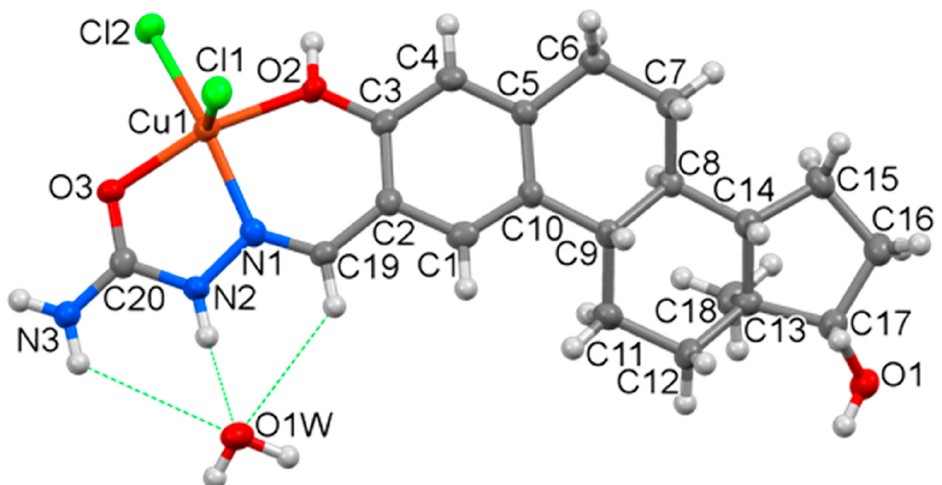
Figure 4. Molecular structure and atom labeling of the Cu(II) complex of estradiol ‐ SC as the [Cu(HL)Cl 2 ] × H 2 O × 2CH 3 OH complex molecule. Displacement parameters are drawn at the 50% probability level, and the methanol solvate molecules are omitted for clarity.